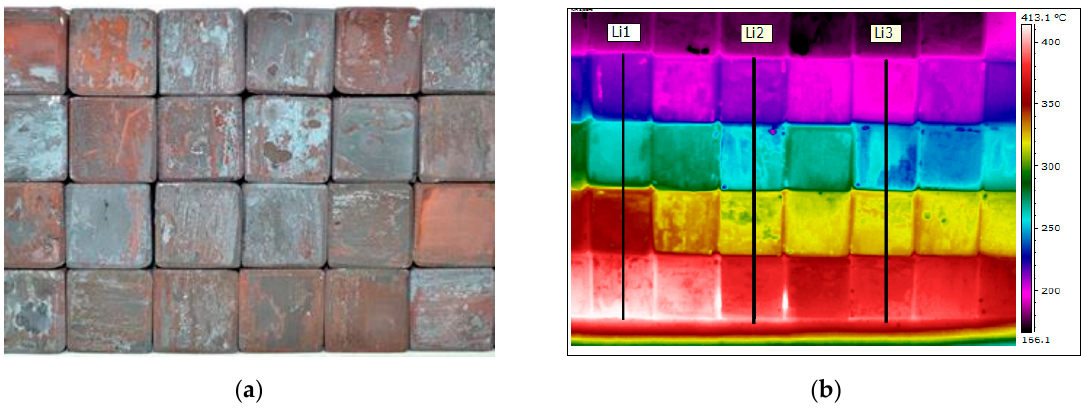
Figure 20. A bed of 20 mm square bars heated in the electric furnace: ( a ) view of the sample; ( b ) one of the thermogram recorded during the test. of the thermogram recorded during the test.